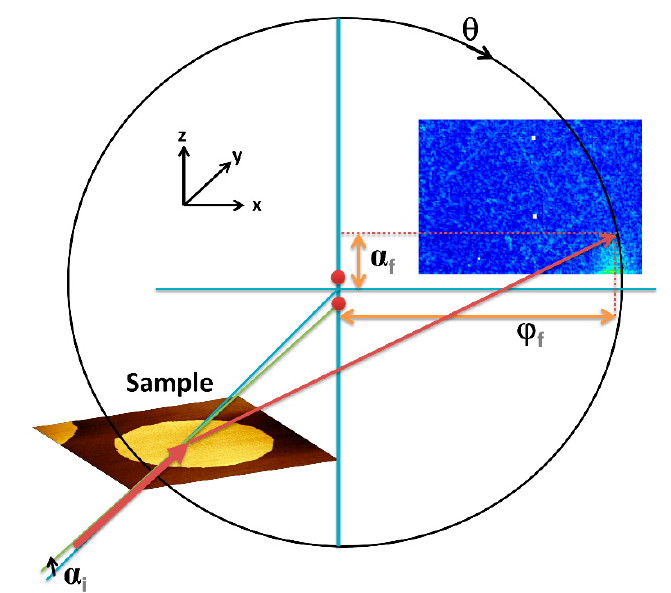
Figure 1. Sample geometry for GI-WAXS measurements .